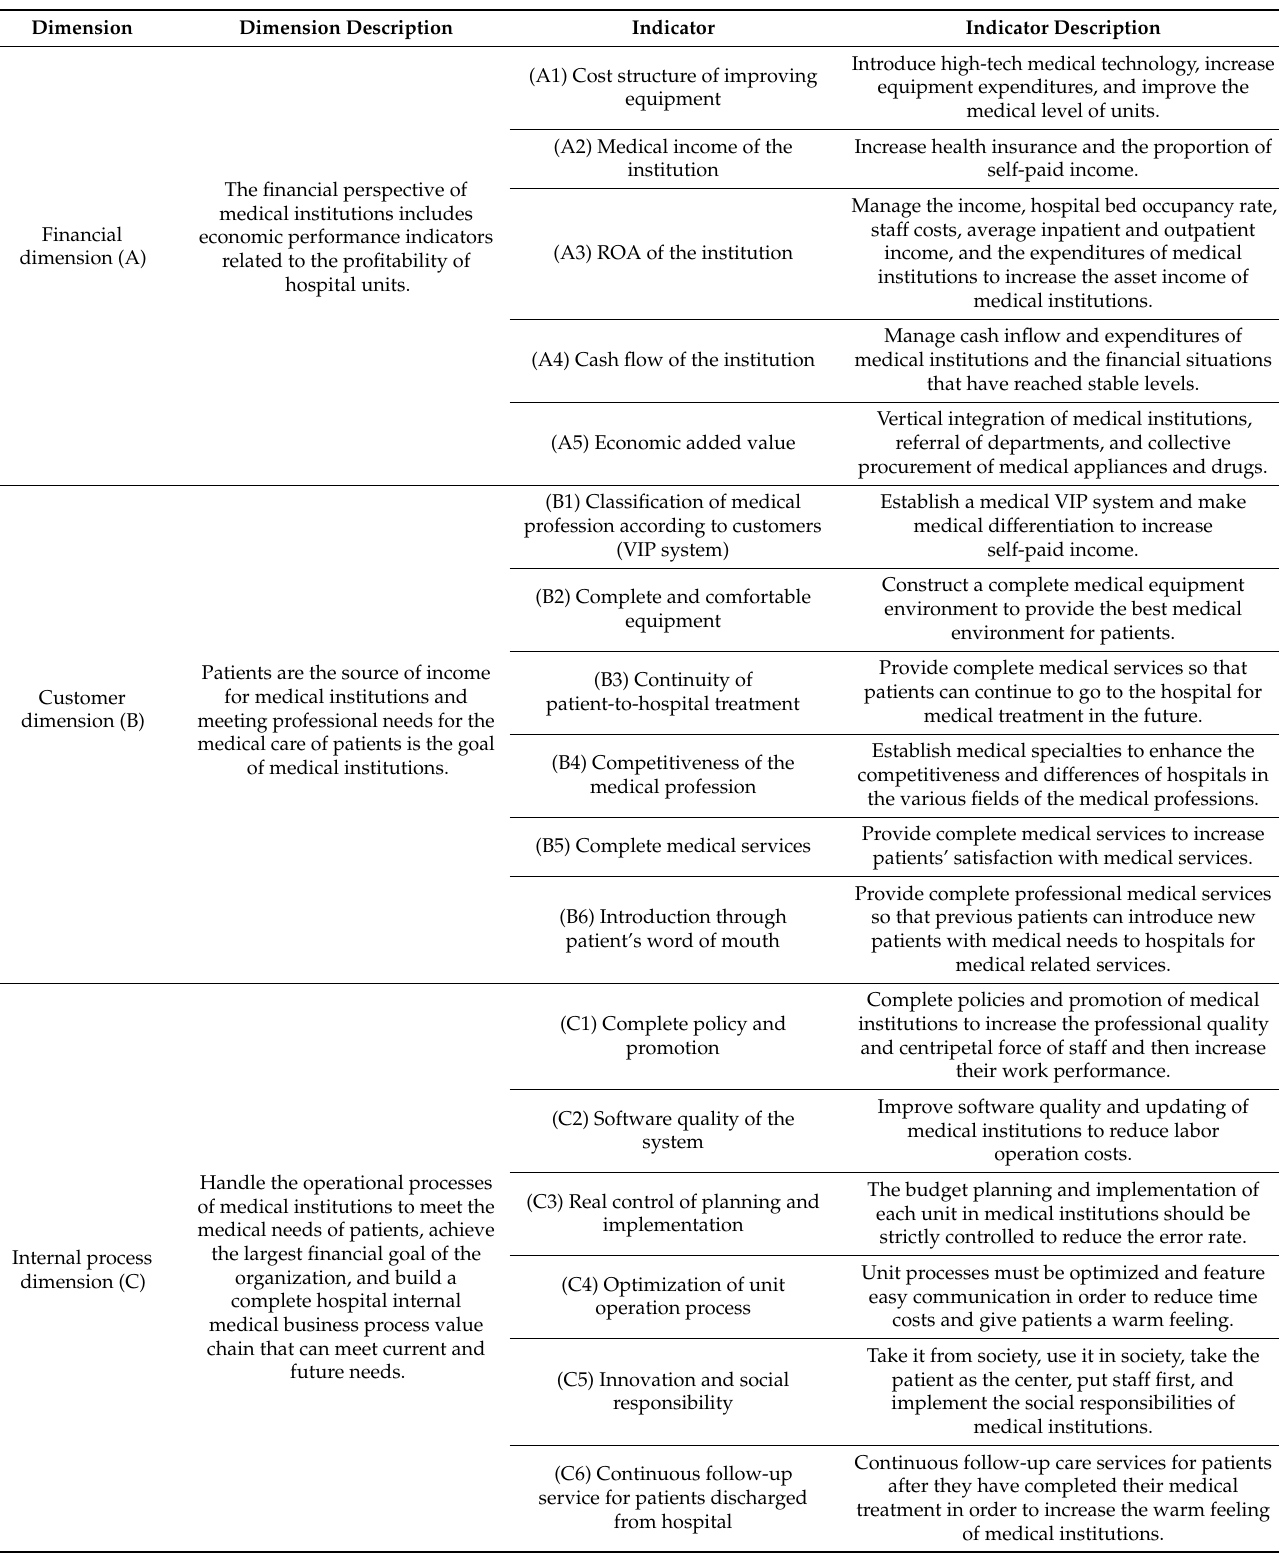
Table 1. Service performance measurements of medical